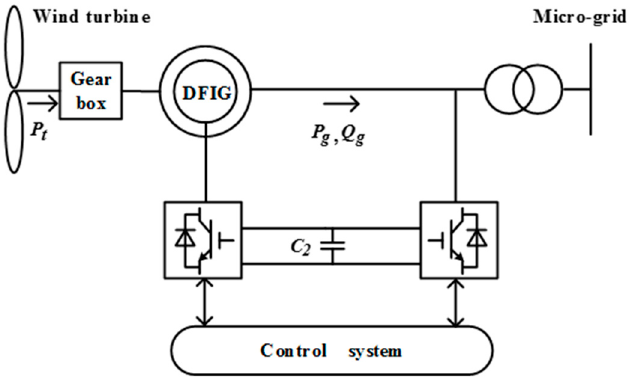
Figure 4. Schematic diagram of a doubly ‐ fed induction generator (DFIG) ‐ based wind turbine connected to the micro ‐ grid.